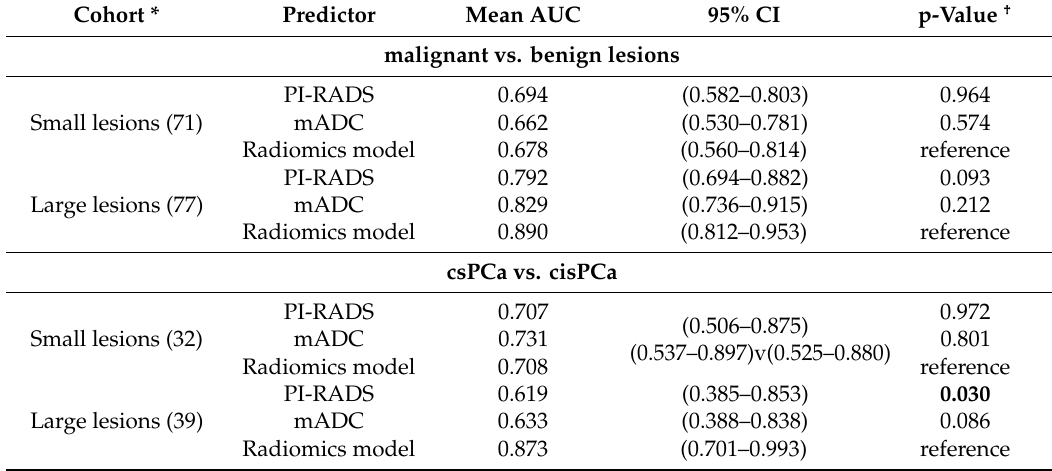
Table 2. Results of ROC analysis for the two selected classification tasks. Table 4. Analysis of patient subgroups with small ( < 0.5 ml) and large ( ≥ 0.5 ml) index lesions in the cross-validation cohort. Predictor malignant vs. benign lesions csPCa vs. cisPCa